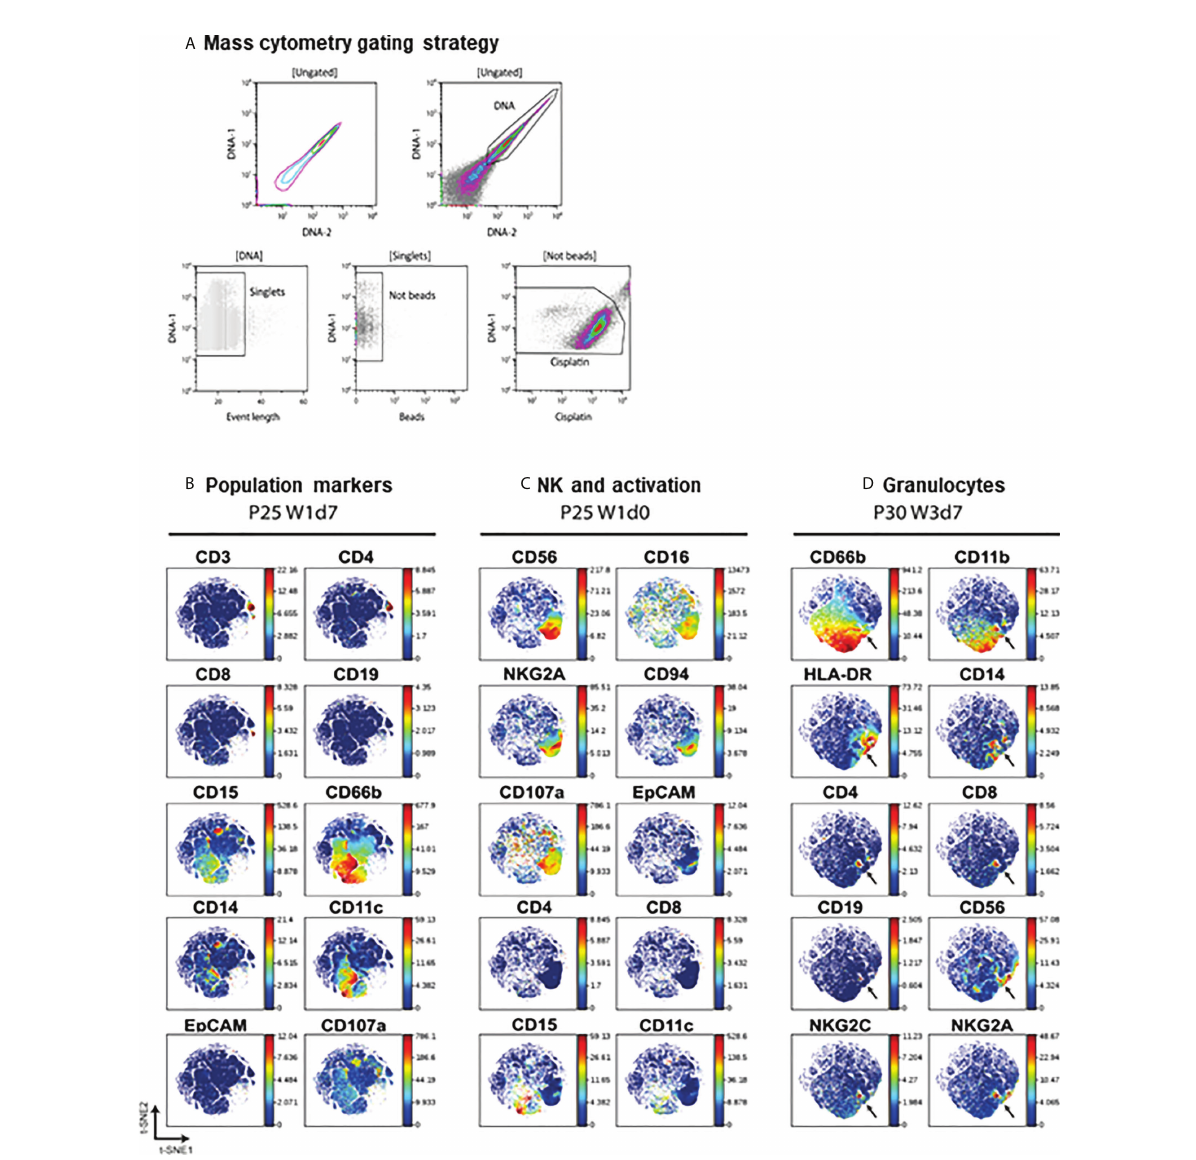
FIGURE 2 Mass cytometry on urine cells. (A) Mass cytometry gating strategy. A fi rst region on the DNA positive events was selected to gate singlets. Calibration beads and cisplatin positive events were then sequentially excluded. (B – D) . Validation of antibody staining by mass cytometry. viSNE analysis were performed separately for different individuals (patients 25 and 30) and several plots were compared to visualise the markers for different immune populations. Arrows indicate an example of a population binding antibody non-speci fi